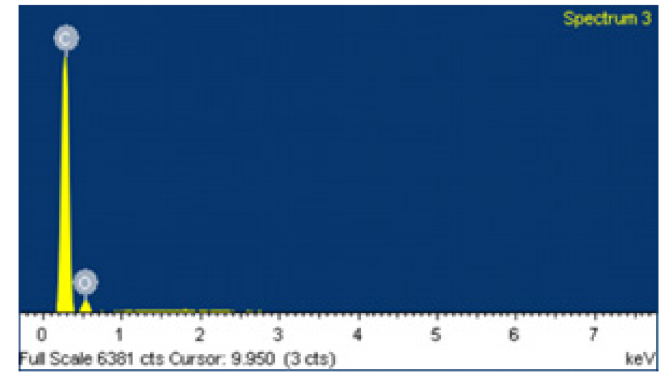
Figure 7. Spectrum processing.